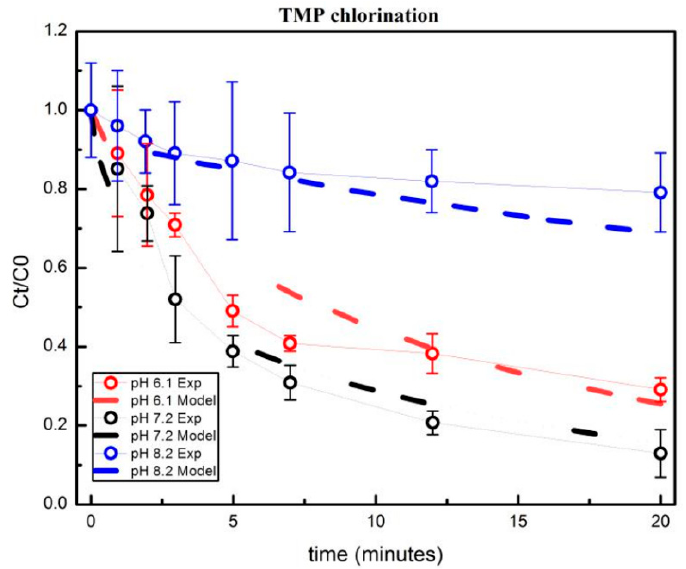
Figure 2. Fitting results of the chlorination of TMP under various pH. Conditions: [TMP] 0 = 0.01 mM, [free chlorine] 0 = 0.05 mM.